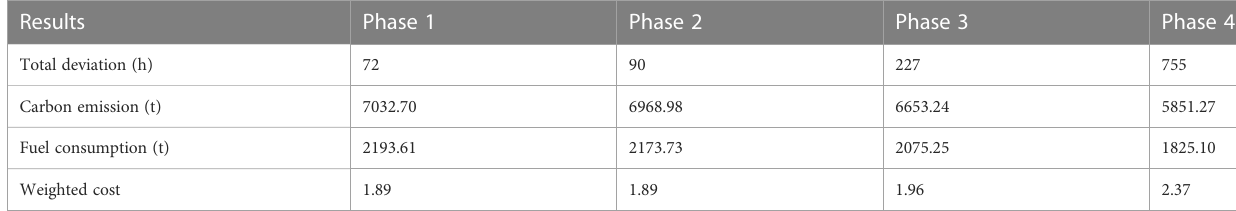
TABLE 7 Results in different